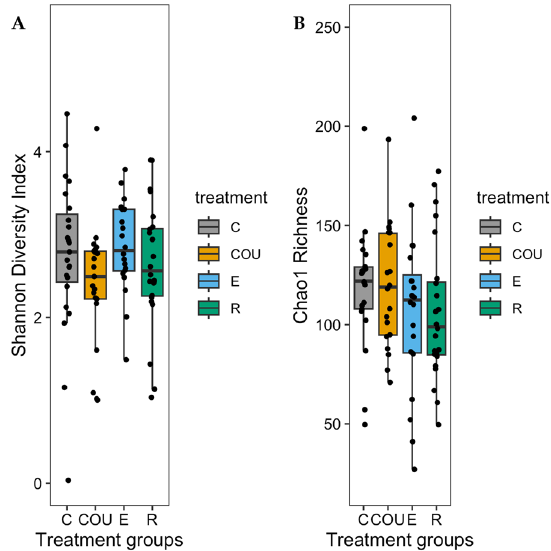
Fig. 3 The gut microbiome alpha diversity of 7‑day‑old great tit nestlings across the four treatment groups visualized with two diversity metrics: A Shannon Diversity Index and B Chao1 Richness. The black dots represent each observation within a treatment group. The whiskers represent 95% confidence intervals. Treatment